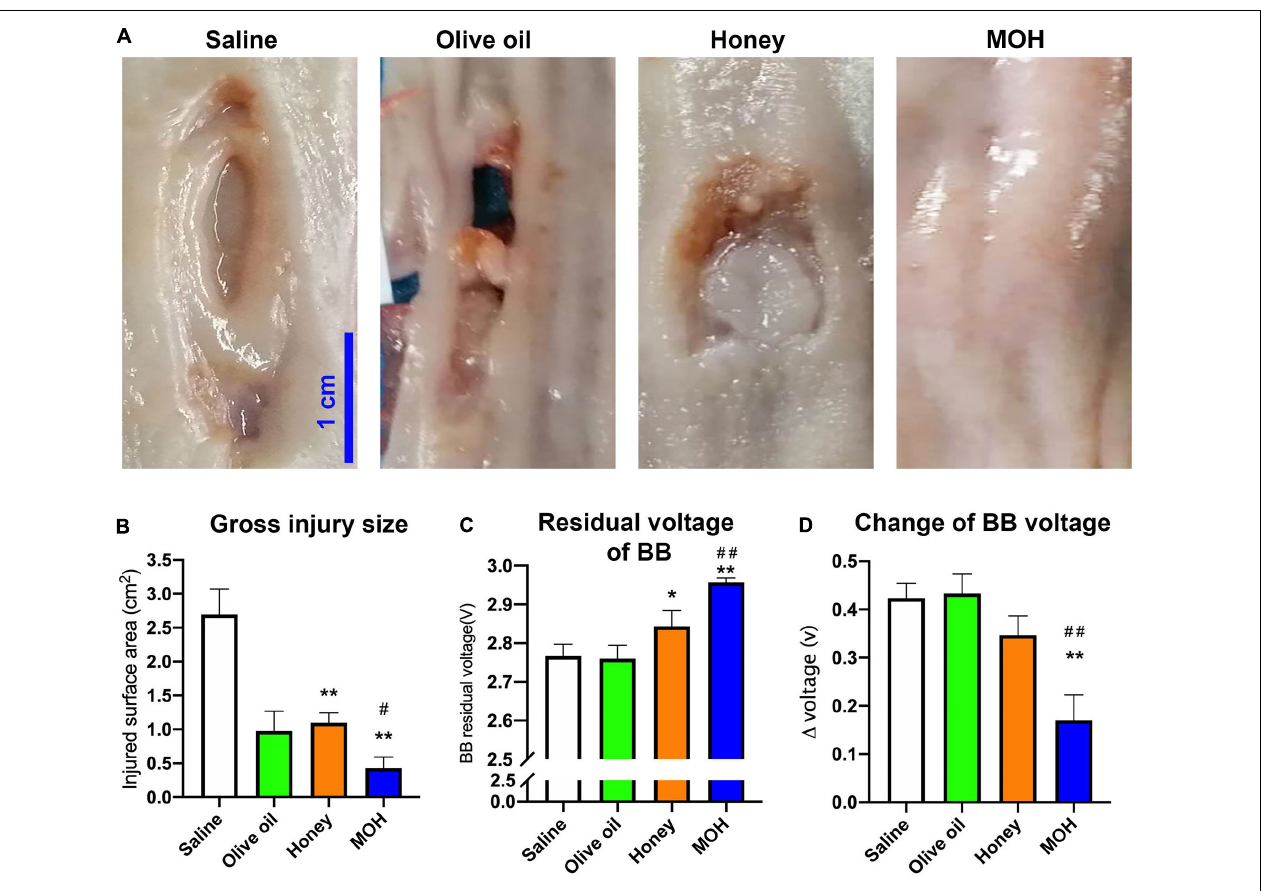
FIGURE 3 | The in vivo effect of different treatments on button battery exposed esophagi ( n = 3). (A) The gross injury of damaged esophagi immediately removed from live animals 7 days after the battery exposure. (B) The surface injury size of damaged esophagi. (C) The residual voltage of button batteries after 60 min exposure. (D) The discharges of placed batteries. * P < 0.05 vs. Saline; # P < 0.05 vs. Honey ; ** P < 0.01 vs. Saline; ## P < 0.01 vs.